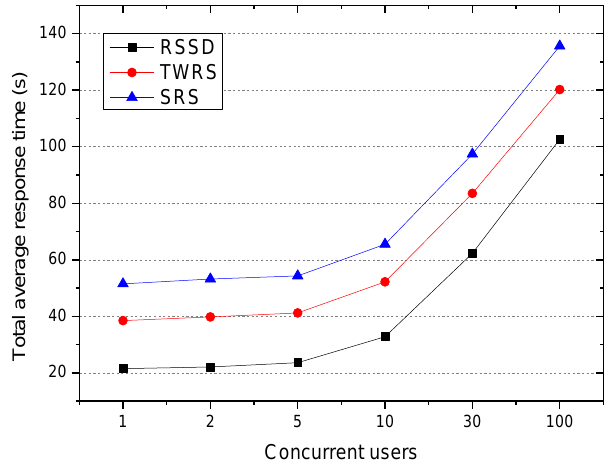
Figure 7. Total average response time.